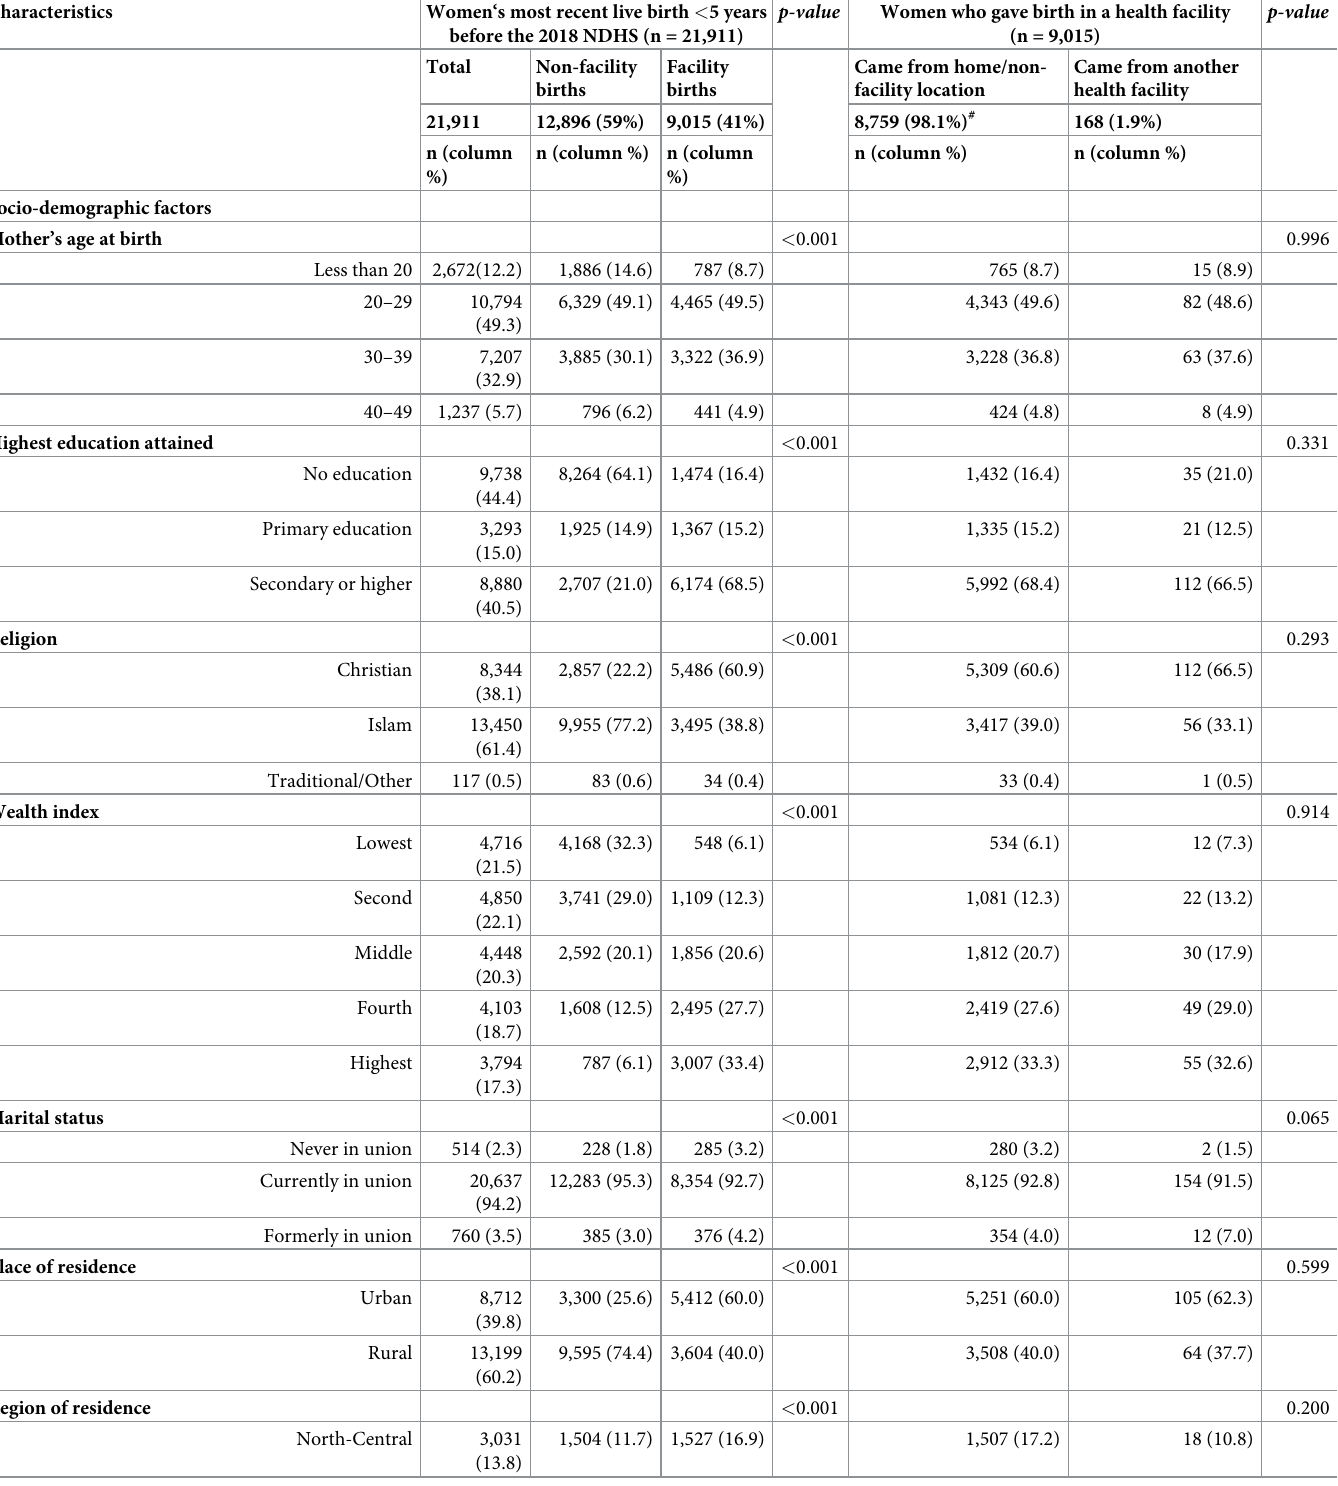
Table 1. Sociodemographic, obstetric factors and transport pathways of all women’s most recent live birth in the five-year recall period of the 2018 Nigeria DHS.